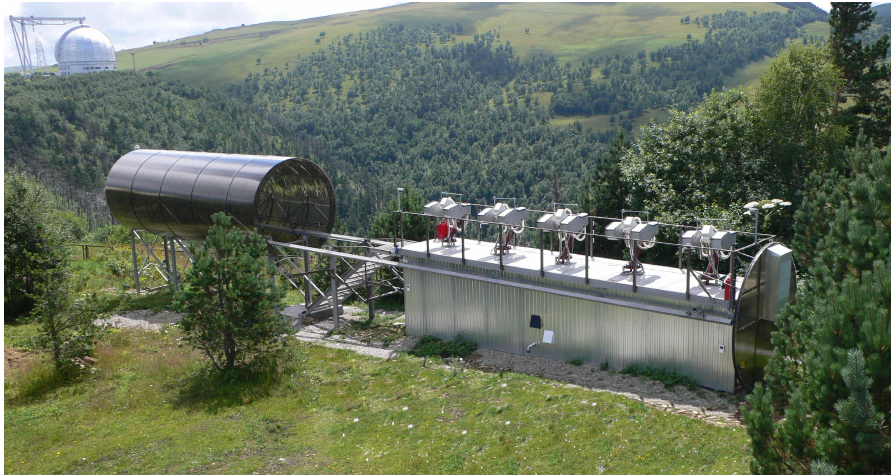
Fig. 3. All the nine MMT channels installed on five mounts in a single cylindrical dome, shown here open. The Russian 6 m telescope is seen in the background. The channels are equipped with Andor Neo sCMOS detectors having 2560 (cid:2) 2160 pixels, 6.4 (cid:22) m each. The field of view of a channel is roughly 9 ◦ (cid:2) 11 ◦ , with